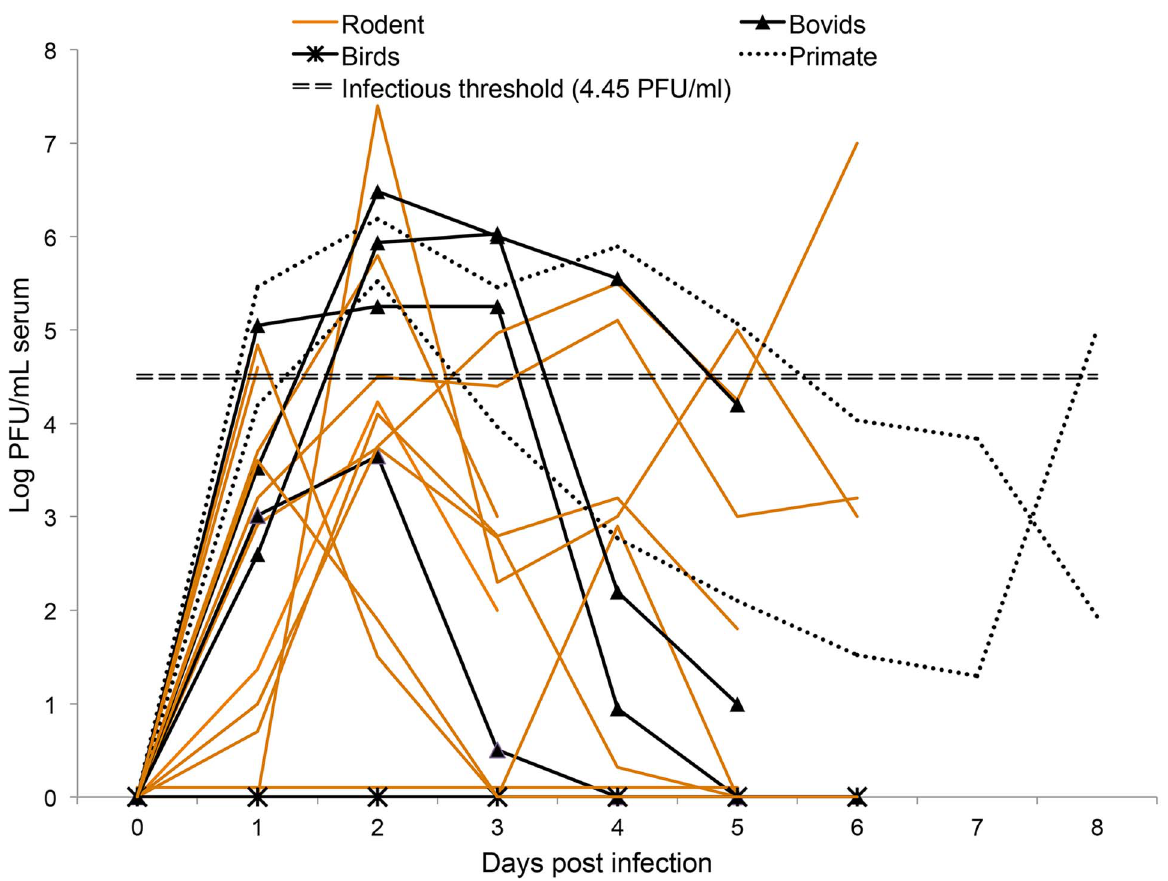
Figure 1. A graphical representation of the mean viremia profiles demonstrated by 20 different vertebrates after exposure to virulent strains of Rift Valley fever virus. Data was compiled from 17 published experimental infection studies and unpublished data from Dr. John Morrill and Dr. Michael Turell. Viral titers were quantified each day after infection by Plaque Assay or Tissue Culture Infectious Dose 50, which was converted to PFU/ml by the following equation: PFU/ml=TCID 50 /ml 6 0.69 [39,40]. When a vertebrate host’s viremia was calculated to be negative the daily infectiousness was set to zero as discussed in the methodology. References: Bovids: [48–51]; Birds: [52] (Turell unpublished data); Primate: [53–55] (Morrill unpublished data); Rodent: